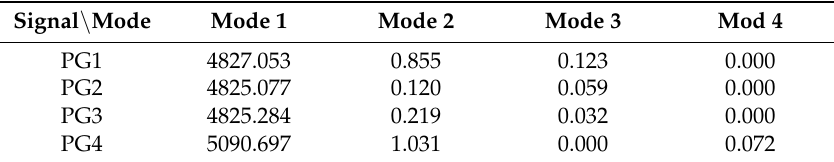
Table 4. Node contribution factor (NCF) matrix in Case 2.